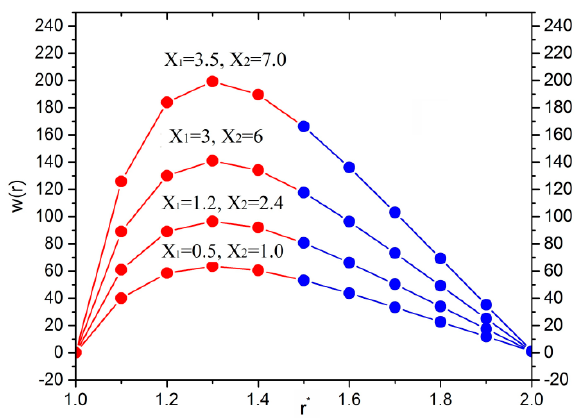
Figure 4. Effect of 𝑋 (cid:2869) and 𝑋 (cid:2870) on velocity when ε𝐷 (cid:2869)(cid:2870) = 5 , ε𝐷 (cid:2870)(cid:2870) = 10 , δ = 2 .